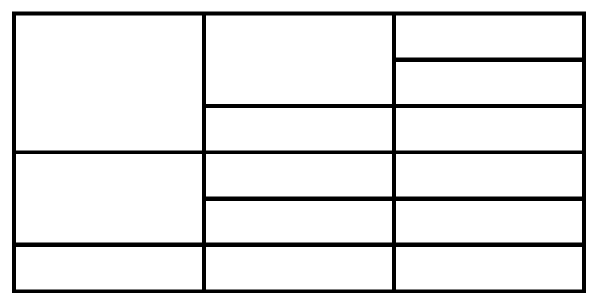
Figure 2. The second table mentioned in the